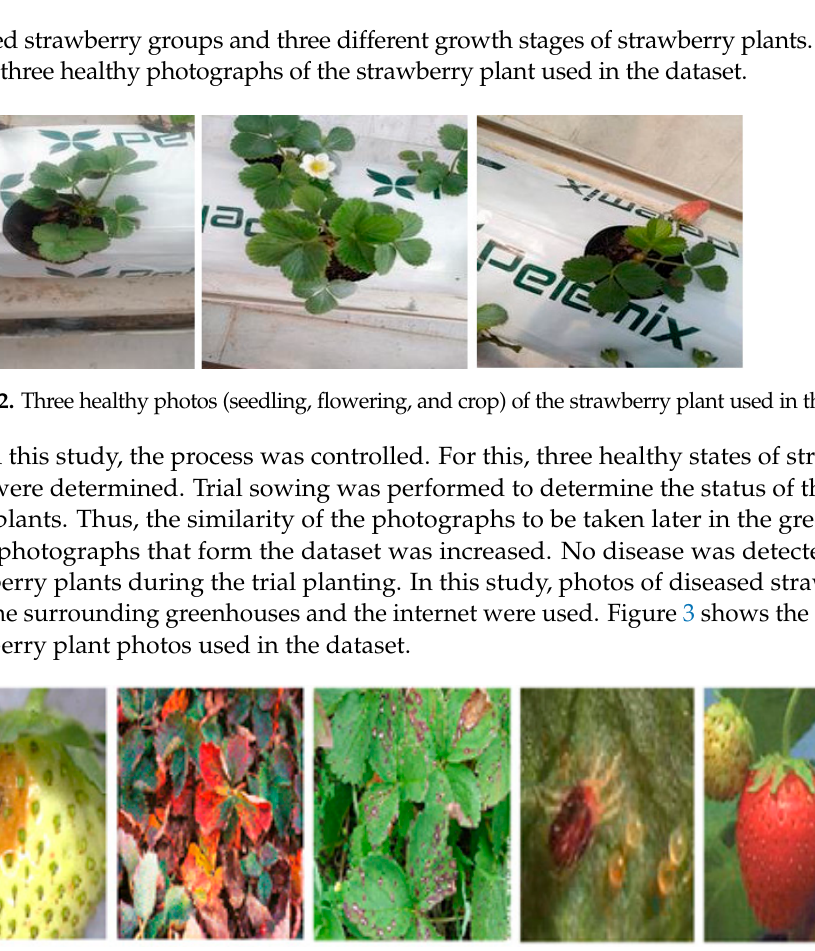
Figure 3. Strawberry diseases (Botrytis cinerea, Sphaerotheca macularis fsp. fragariae, Mycosphaerella fragariae, Tetranychus urticae, Frankliniella occidentalis) used in the dataset.